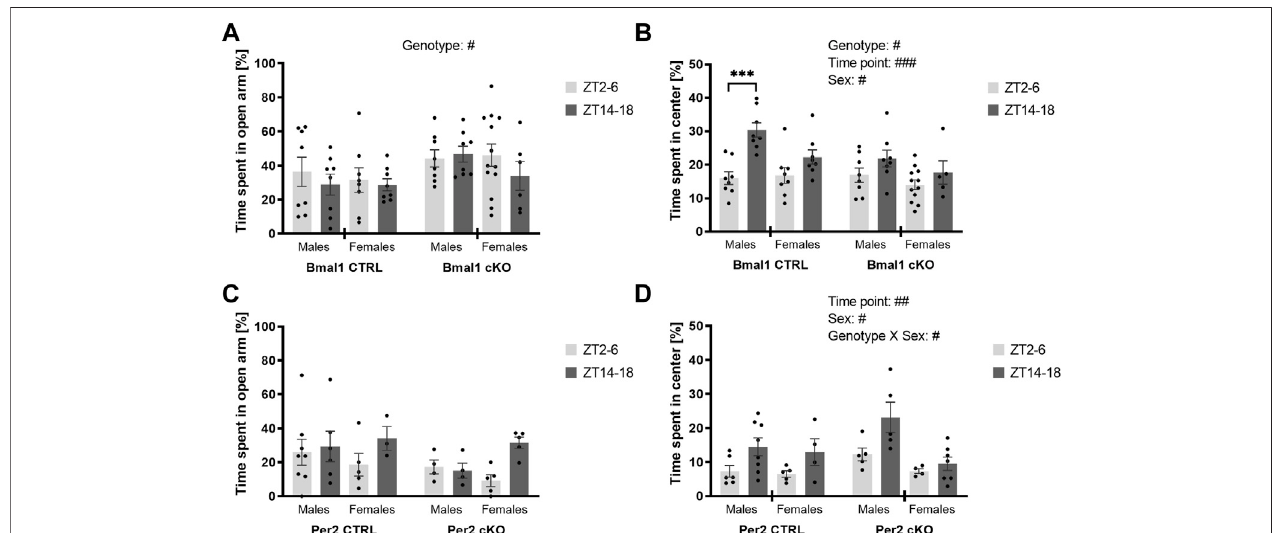
FIGURE 1 | Anxiety-like behavior in mice with a striatal-speci fi c clock gene knockout. Time spent in the open arm of the elevated plus-maze and time spent in the centerofanopen fi eldwasinvestigatedduringthelight(ZT2 – 6,lightgreybar)andthedarkperiod(ZT14 – 18,darkgreybar).Micewithaconditional Bmal1 knockout(n= 6 – 13 per genotype, sex, and time point) displayed decreased anxiety-like behavior in the elevated plus-maze compared to controls (A) , whereas increased anxiety-like behaviorwasobservedinthe open fi eld test (B) . Theconditionalknockout of Per2 (n=3 – 8per genotype, sex, and time point)did notaffectanxiety-like behavior in theelevatedplus-mazeandopen fi eld (C,D) .Resultsaredepictedasmean±standarderrorofthemean(S.E.M.).# ... p ≤ 0.05,## ... p ≤ 0.05,### ... p ≤ 0.05,three-